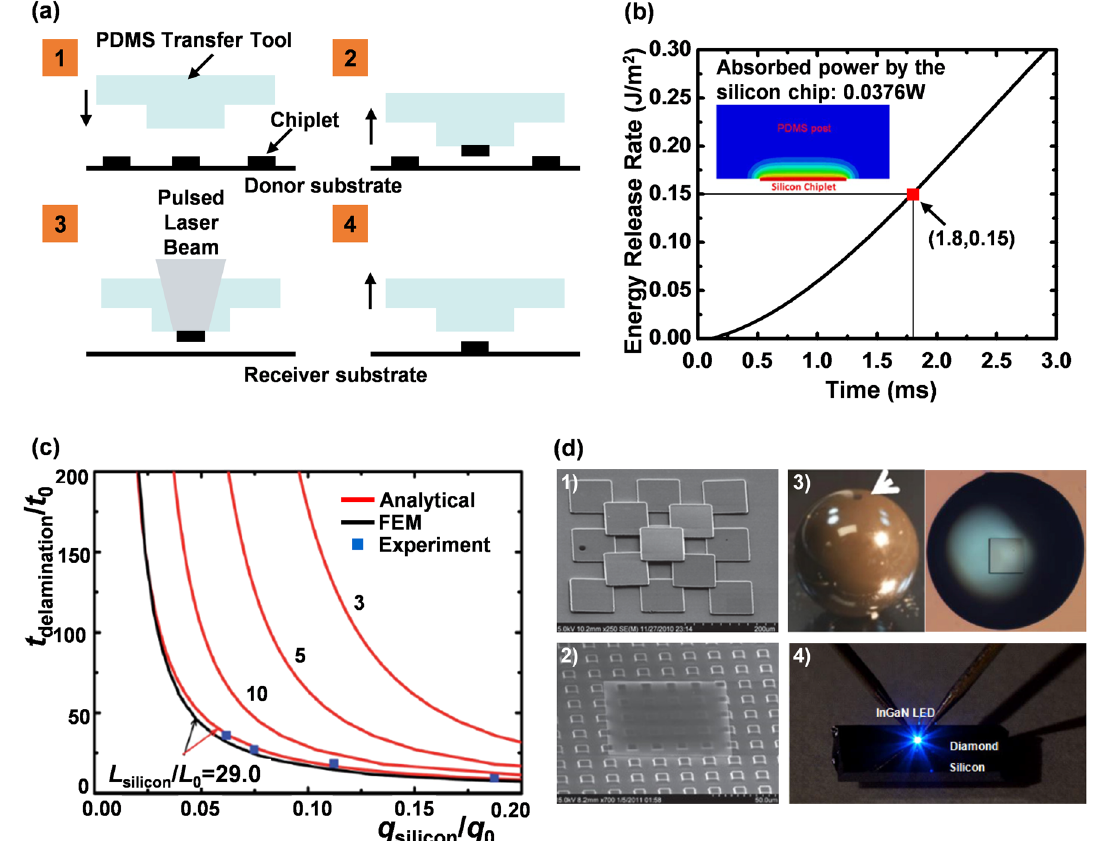
Fig. 5 Laser-driven non-contact transfer printing technique. a Illustration of the laser-driven non-contact transfer printing process. Adapted with permission from ref. 72 b Energy release rate at the crack tip versus time. Inset: temperature distribution in the stamp and the attached chiplet at 1.8 ms. Adapted with permission from ref. 72 c The scaling law for the delamination of the stamp/silicon interface. Reprinted with permissions from ref. 74 d Structures fabricated using the laser-driven non-contact transfer printing technique. ( 1 ) Three-dimensional pyramid built with the same silicon squares. Reprinted with permissions from ref. 72 ( 2 ) 100 μ m × 100 μ m × 0.32 μ m ultrathin Si square placed onto a structured substrate. Reprinted with permissions from ref. 72 ( 3 ) Examples of printing on curved surfaces, (left) printing on a single 1 mm ceramic sphere and (right) printing onto a liquid NOA droplet. Reprinted with permissions from ref. 73 ( 4 ) Functioning μ -LED placed on a CVD- grown polycrystalline diamond on silicon substrate. Reprinted with permissions from ref.